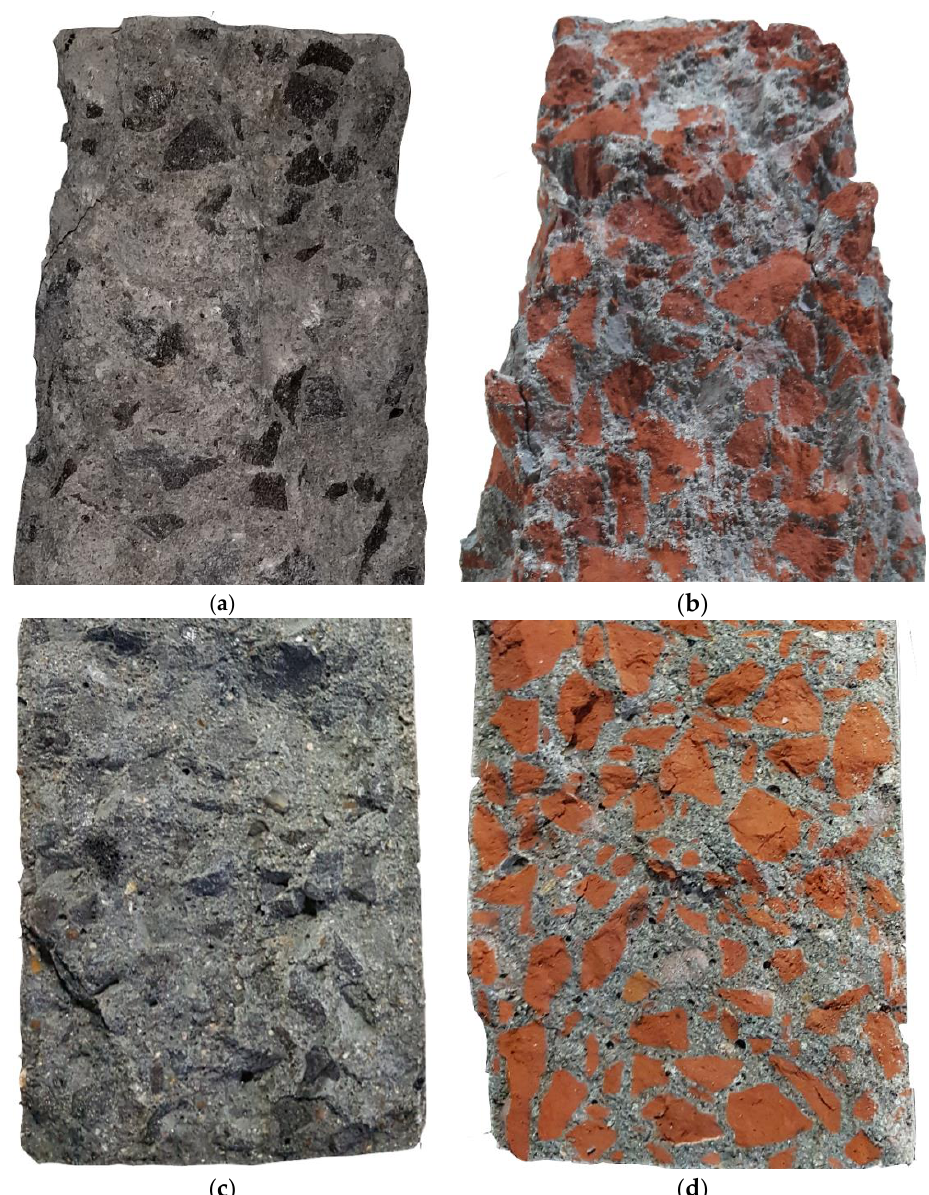
Figure 8. Fracture surface after compressive strength test of SSA concrete ( a ) BA concrete ( b ) and splitting tensile strength test of SSA concrete ( c ) and BA concrete ( d ) samples.